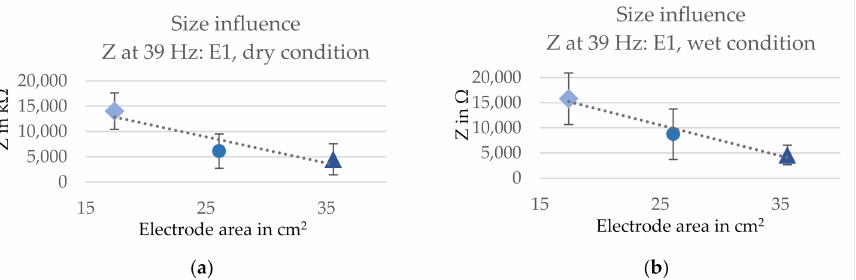
Figure 6. Influence of the size on the three-electrode contact impedances for electrode version E1 at 39 Hz in ( a ) dry and ( b ) wet condition. SD indicated with error bars and linear trend line as dashed line.